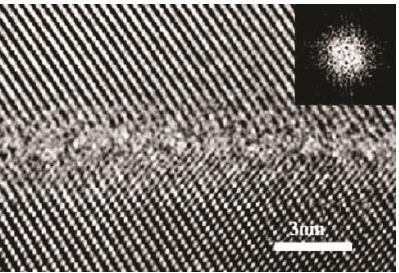
Figure 5. High-resolution TEM image of an amorphous region at the nanoscale (the bar in the figure is 3 nm long) formed using shock loading in B 4 C. The inset is a fast Fourier transform pattern from the amorphous (central horizontal) zone, highlighting its amorphous nature. Figure reprinted from Scripta Materialia , “Amorphization in Mechanically Driven Material Systems”, by E. Ma, 49, 941–946, 2003, with permission from Elsevier